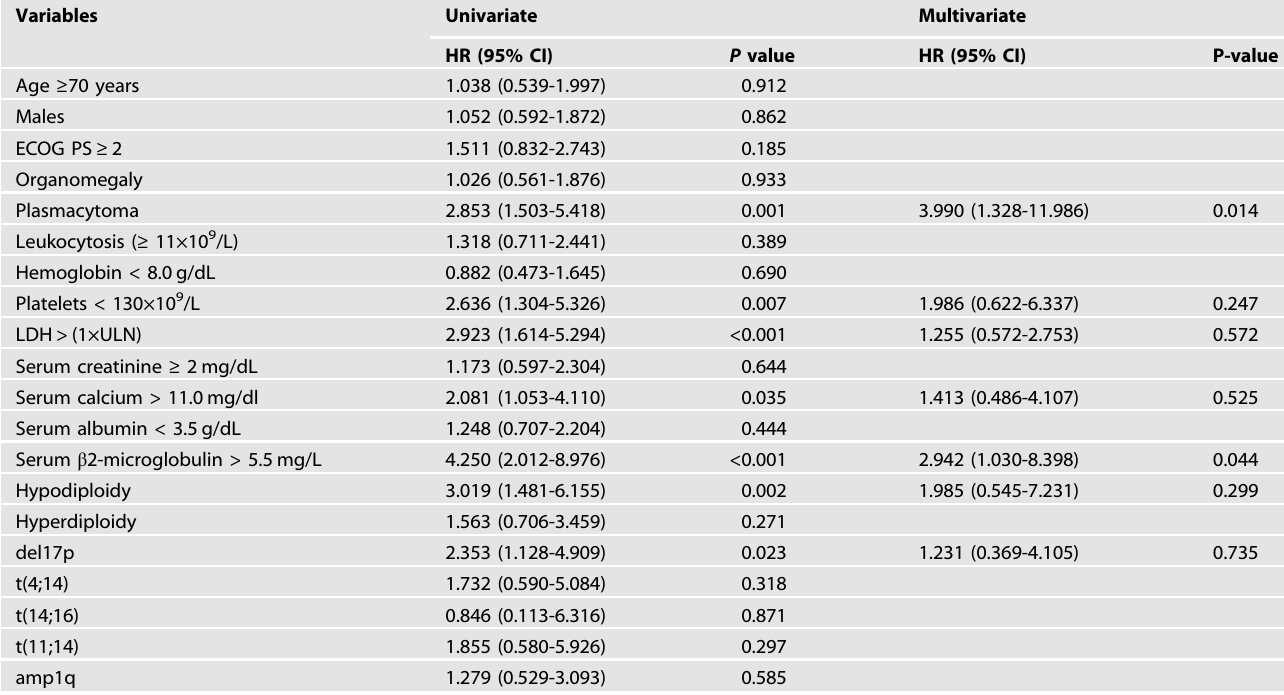
Table 2. Univariate and multivariate analyses of predictors of overall survival in patients with CPCs ≥ 5% ( n =